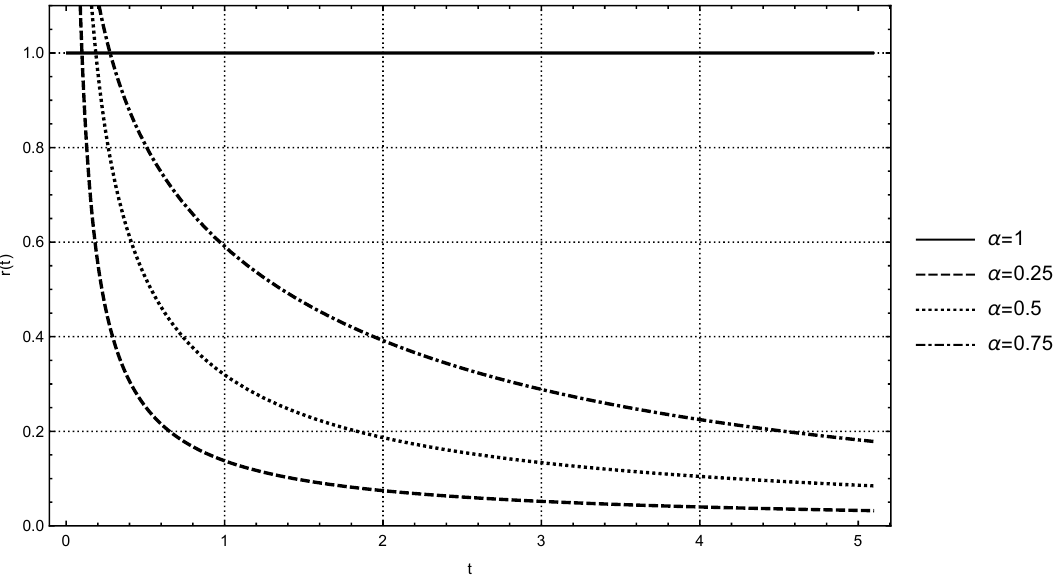
Figure 3. Plots of the ratio r α ( t ) for α = 0.25,0.50,0.75,1 versus t ∈ [ 0,5 ] .